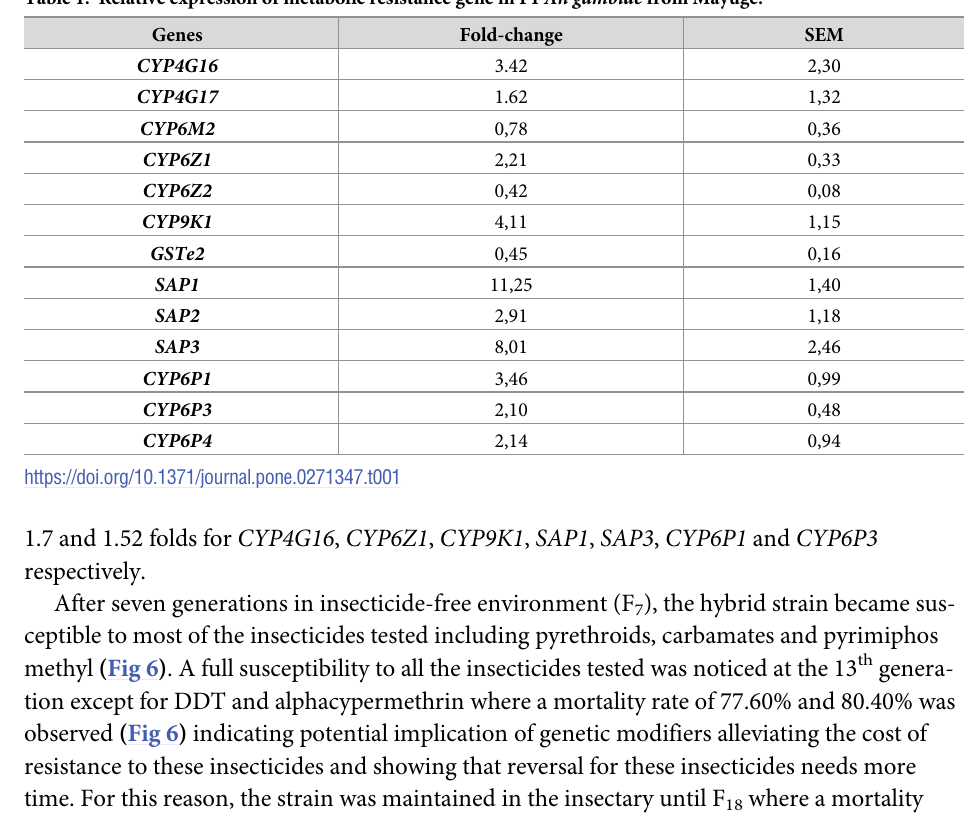
Table 1. Relative expression of metabolic resistance gene in F1 An gambiae from Mayuge.